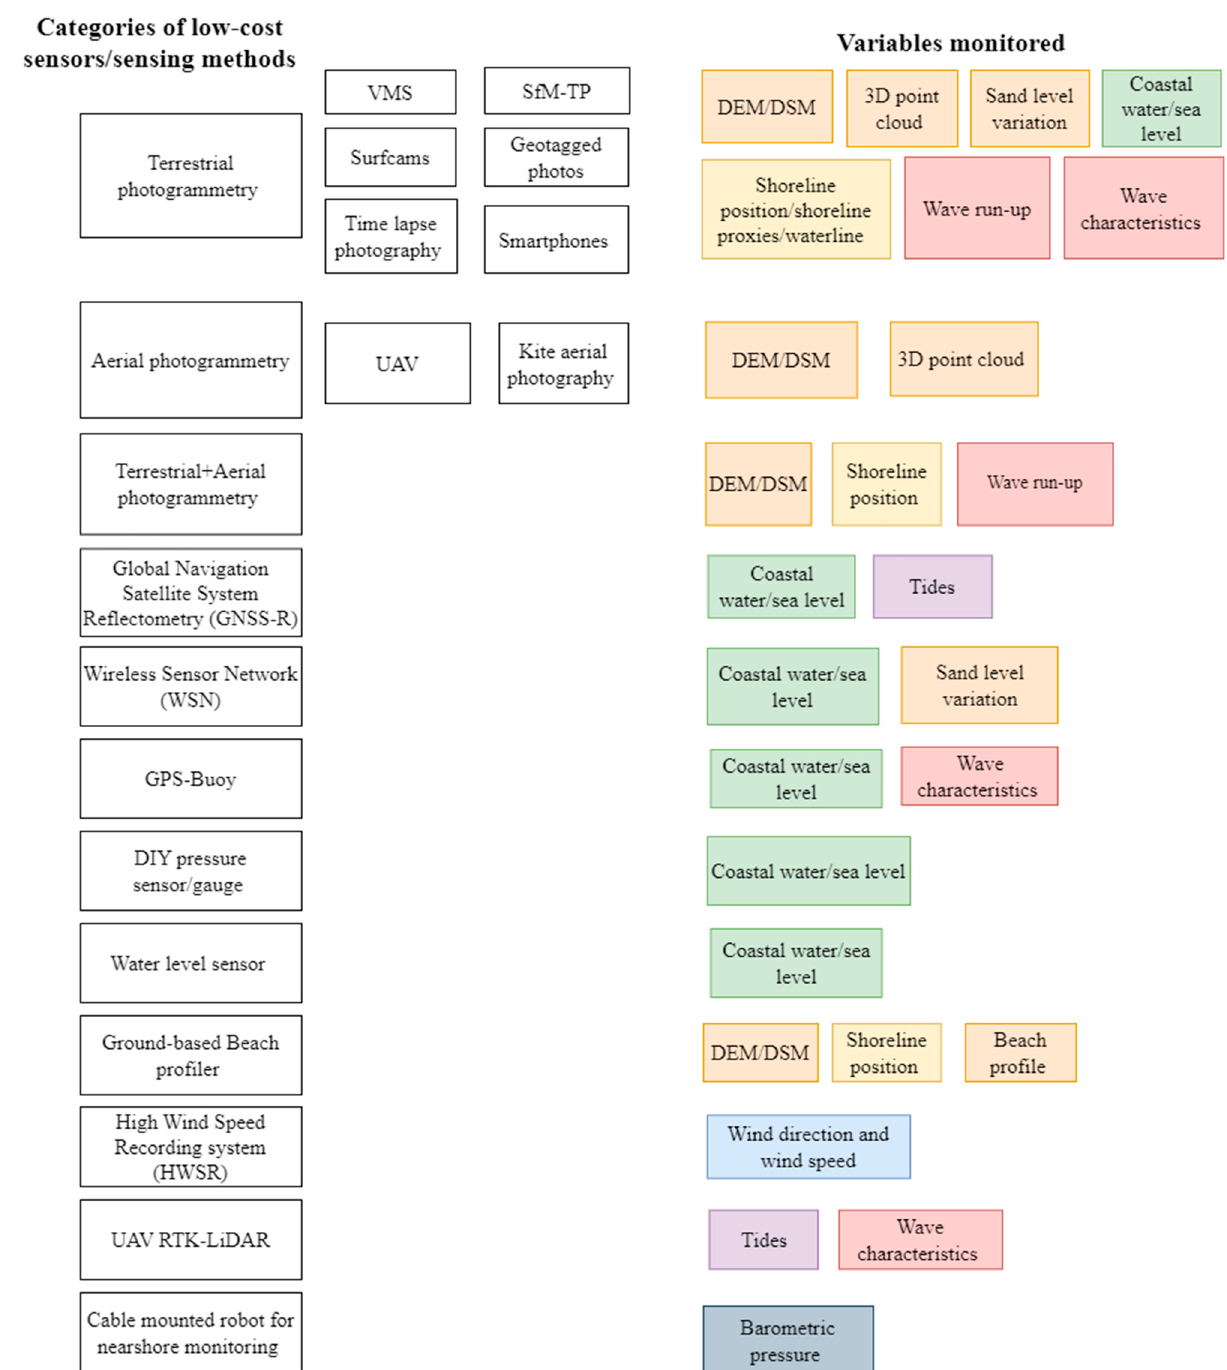
Figure 4. The different variables obtained from the sensors/sensing methods; variables have been colour coded, with similar variables being coloured the same. colour coded, with similar variables being coloured the